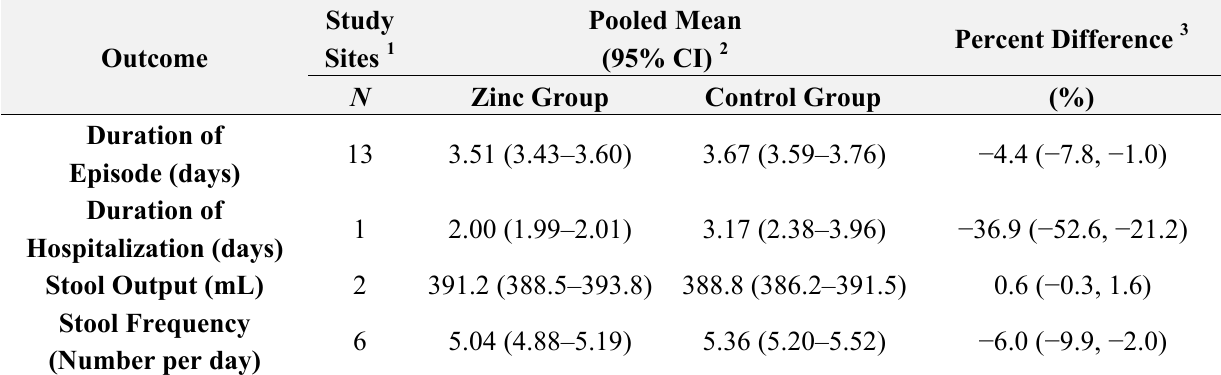
Table 2. Pooled means of select outcomes for non-Chinese studies.